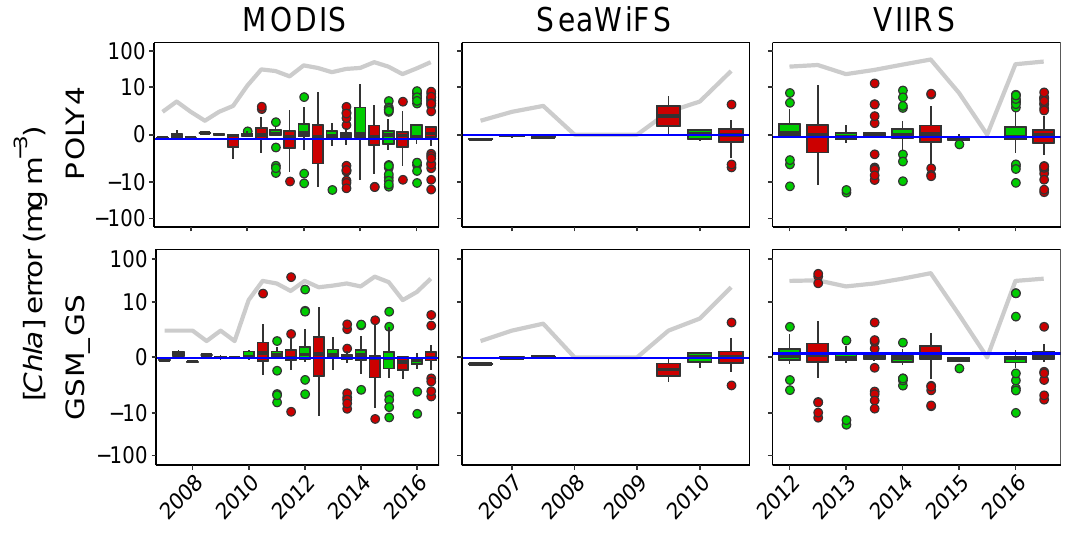
Figure 7. Same as Figure 6, for the